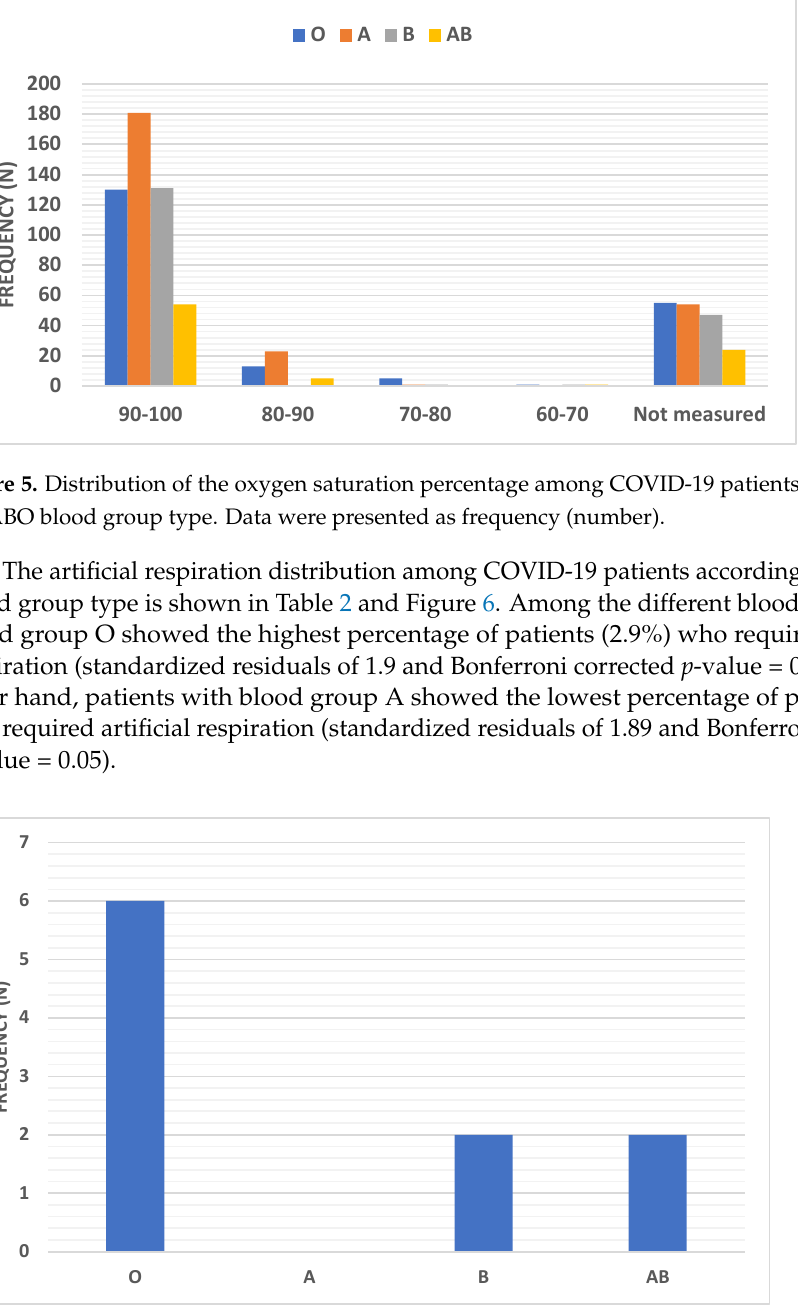
Figure 6. Distribution of the artificial respiration among COVID-19 patients according to the ABO blood group type. Data were presented as frequency